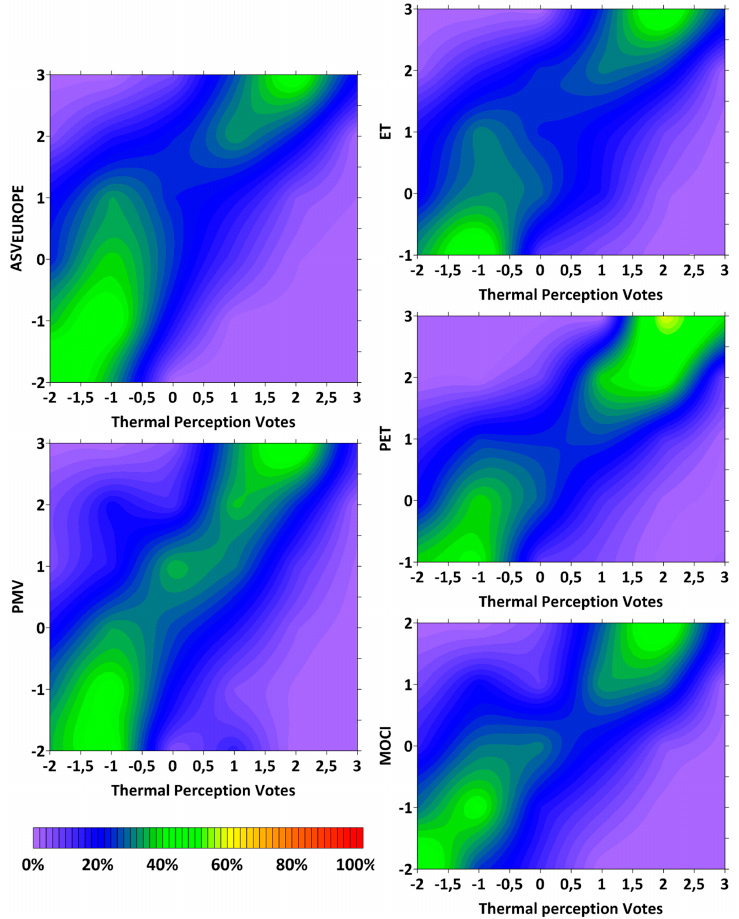
Figure 2. Relation between the classes predicted by the indices and the thermal perception votes.